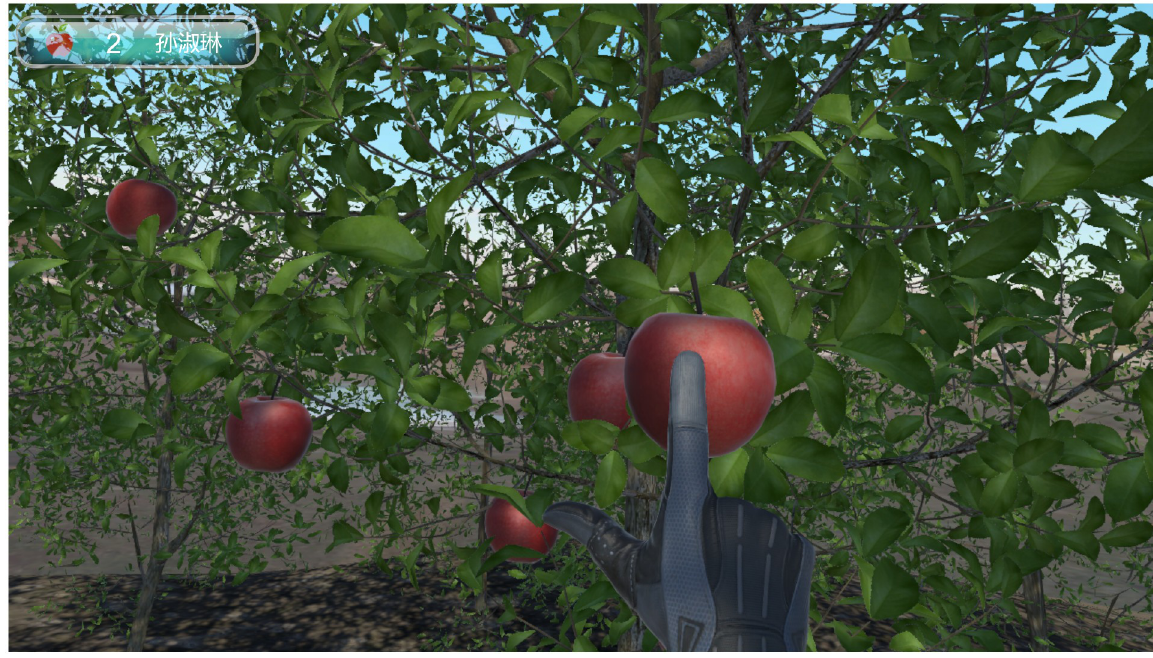
Fig 1. Screenshot of virtual reality rehabilitation interface